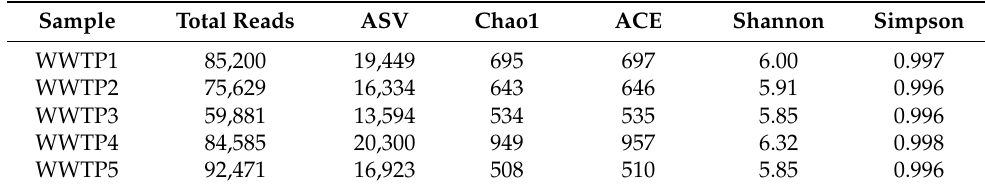
Table 2. Community diversity of influent wastewater samples from five